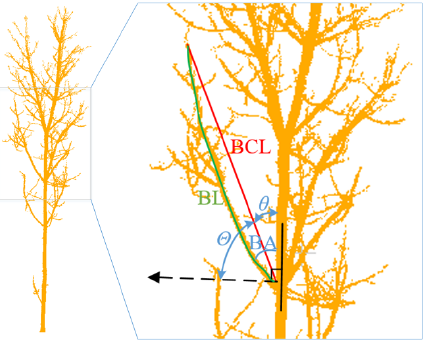
Figure 9. Some attributes of a